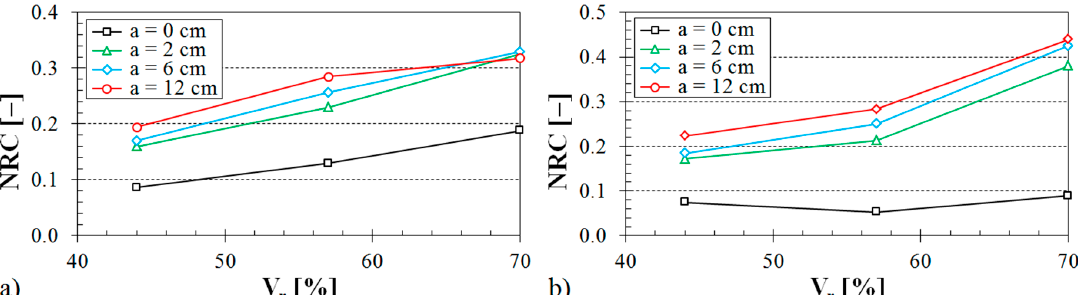
Figure 15. Influence of the air space size on the noise reduction coefficient vs. volume ratio for the investigated ABS samples: ( a ) Rhomboid structure, sample thickness t = 2 cm; ( b ) Starlit structure, sample thickness t = 1 cm.